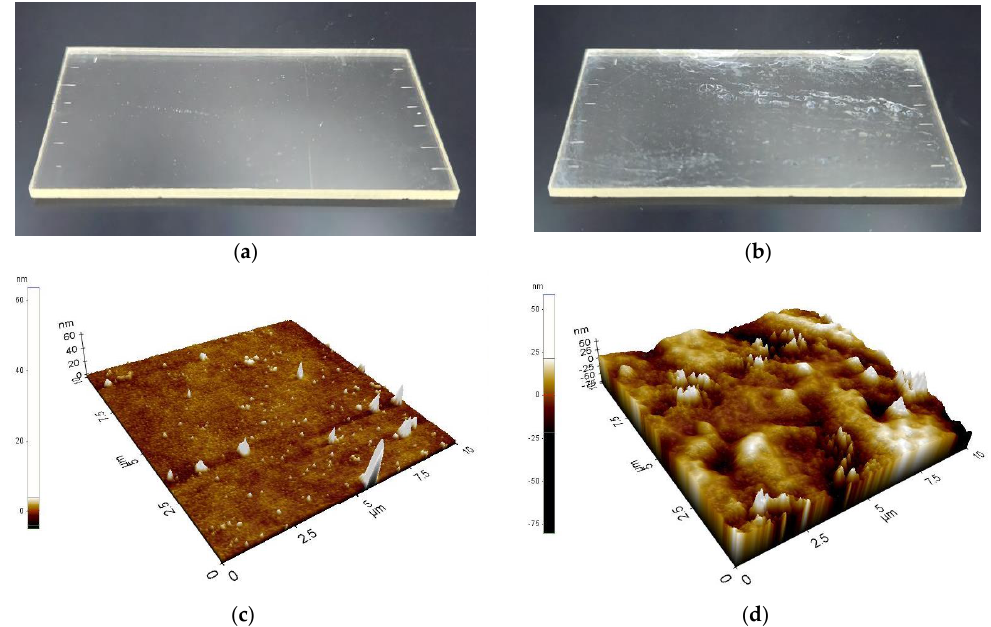
Figure 8. ( a ) Non-rinsed PMMA sheet after 30 min of UV exposure. ( b ) Rinsed PMMA sheet with IPA after 30 min of UV exposure. ( c ) AFM 3D scan image of PMMA surface of ( a ). The measured rms roughness is 0.6 nm. ( d ) AFM 3D scan image of the surface of ( b ). The measured rms roughness is 8.62 nm.